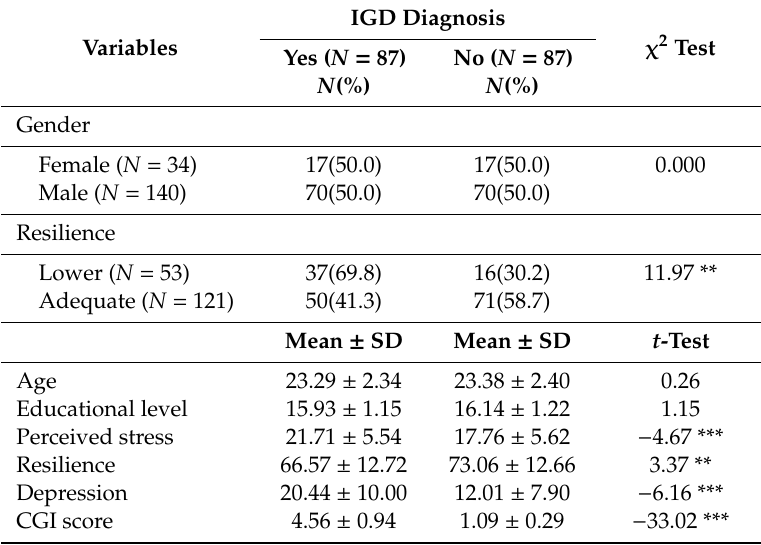
Table 1. Associations of age, educational level, gender, perceived stress, depression, Clinical Global Impression score, and resilience with Internet gaming disorder (IGD).